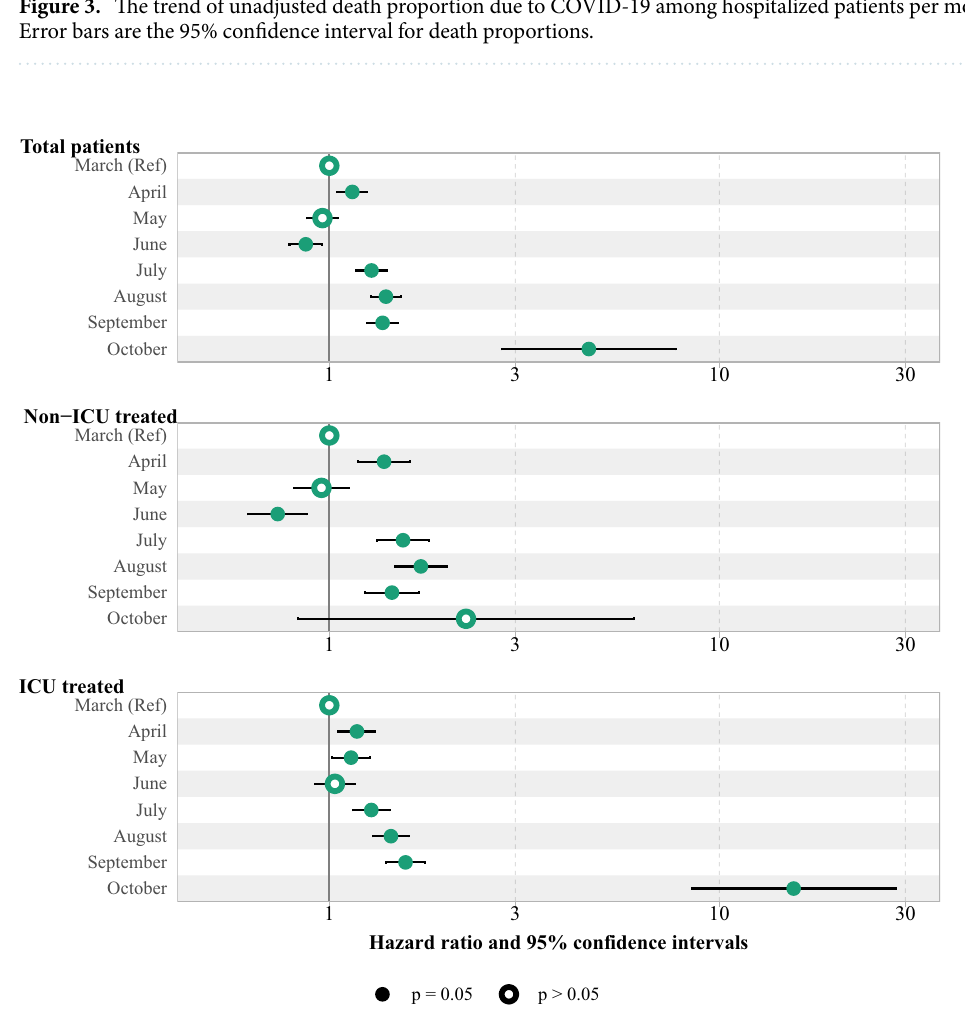
Figure 4. The adjusted HR and 95% CI of death among hospitalized COVID-19 patients by wards. The Cox proportional model was adjusted by variables including sex, age, No. of comorbidities and